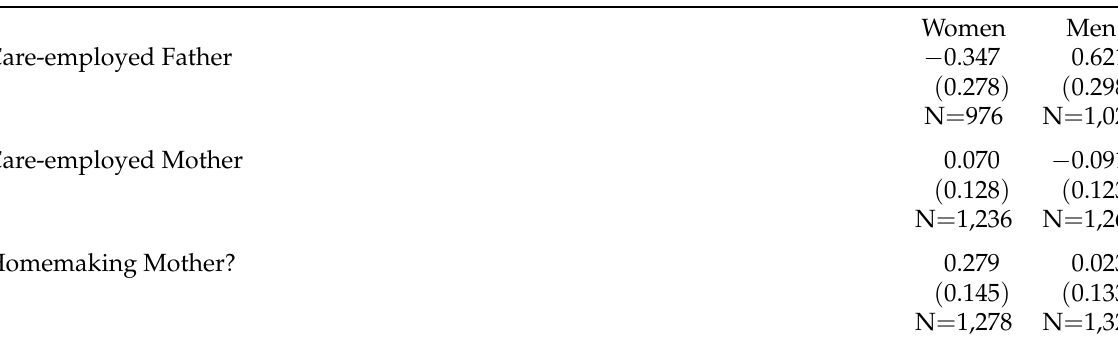
Table 4: Effects of Parental Care Status on Respondents’ “Ethos of